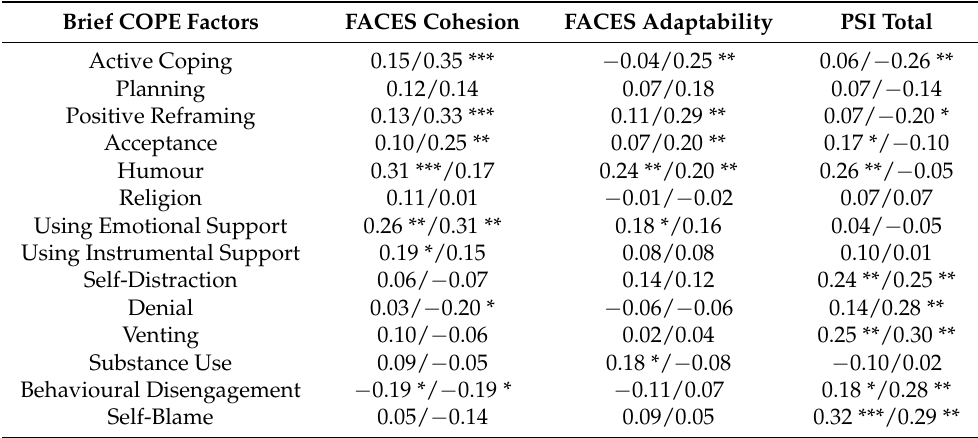
Table 6. Brief COPE correlation matrixes between its dimensions and family cohesion, adaptability and parenting stress (community/at-risk